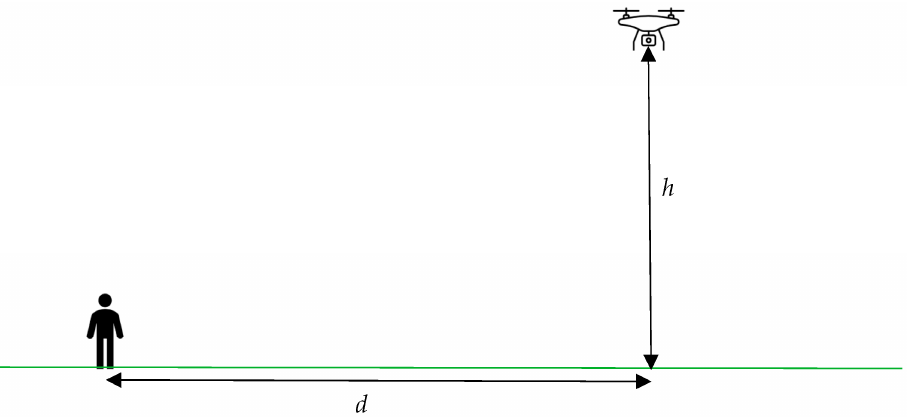
Figure 2. Distance d and Elevation h Parameters Used for Image Capture.